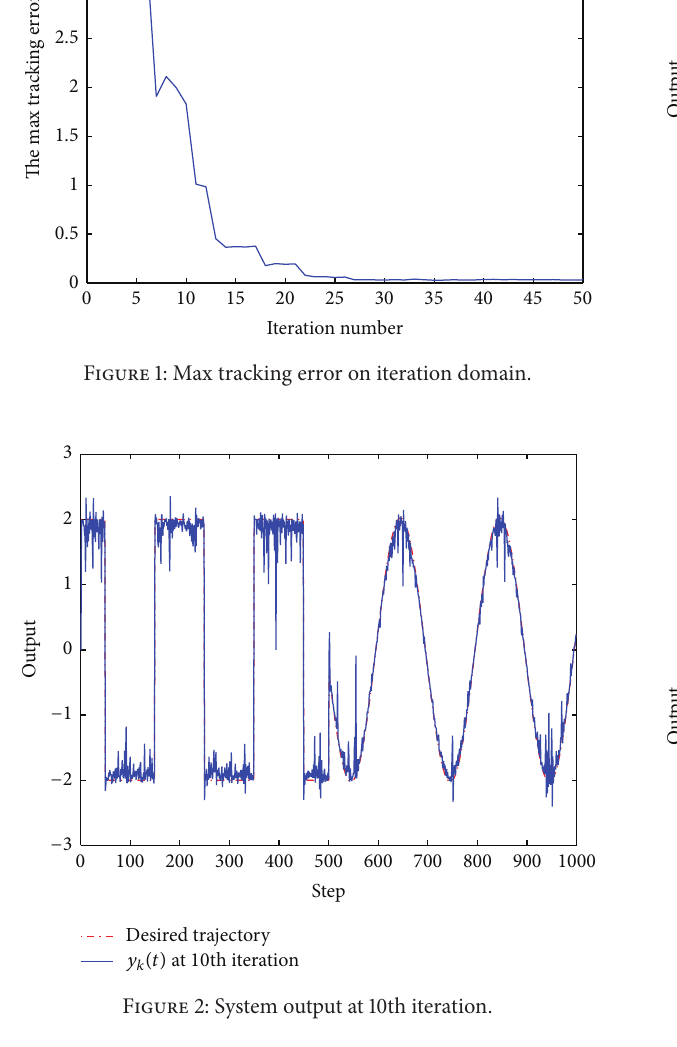
Figure 4: System output at 50th